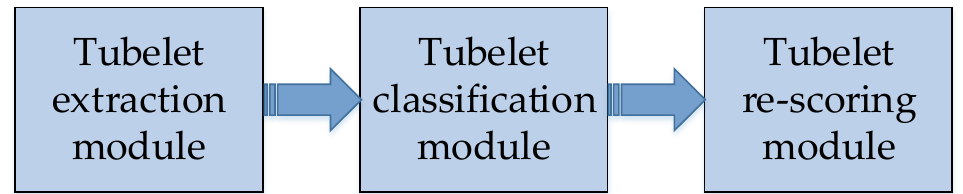
Figure 17. The flow chart of T-CNN.